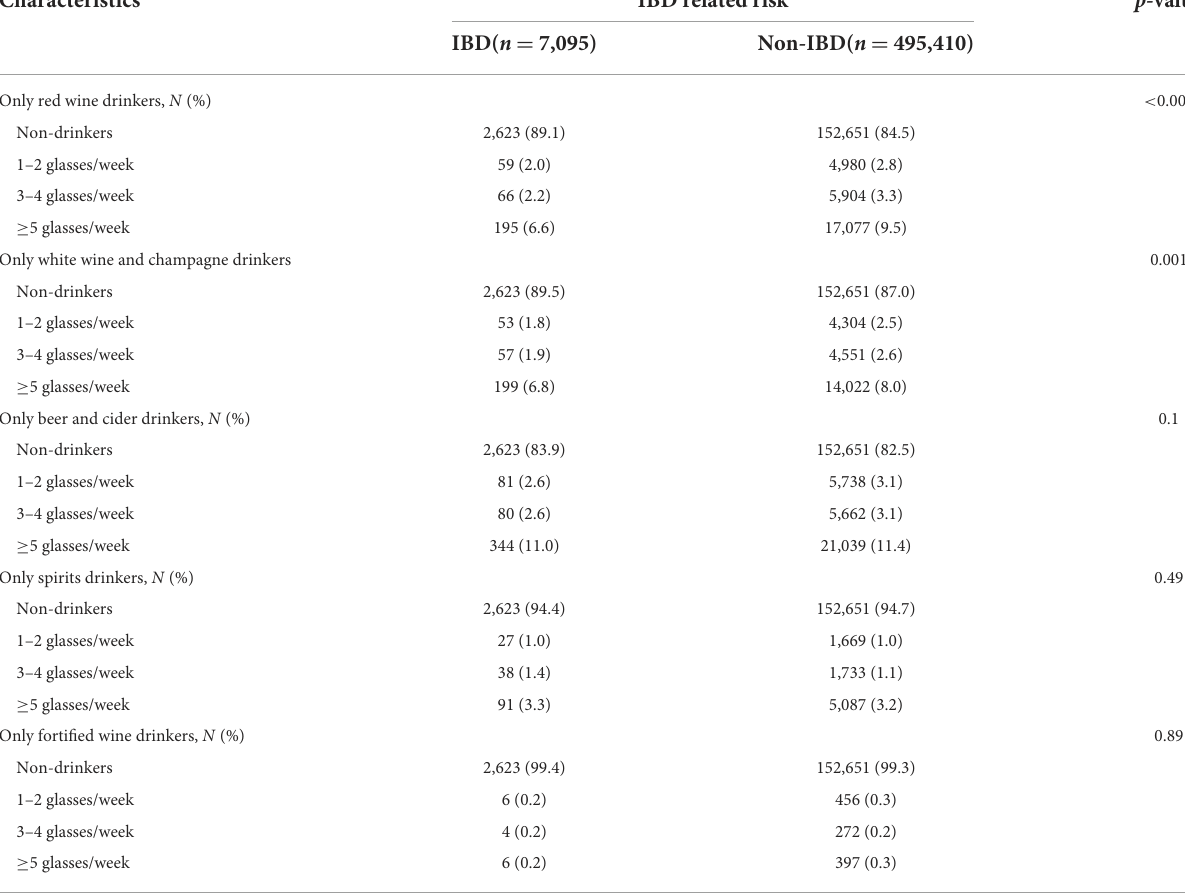
TABLE 3 Characteristics of those subjects who only consumed one alcoholic